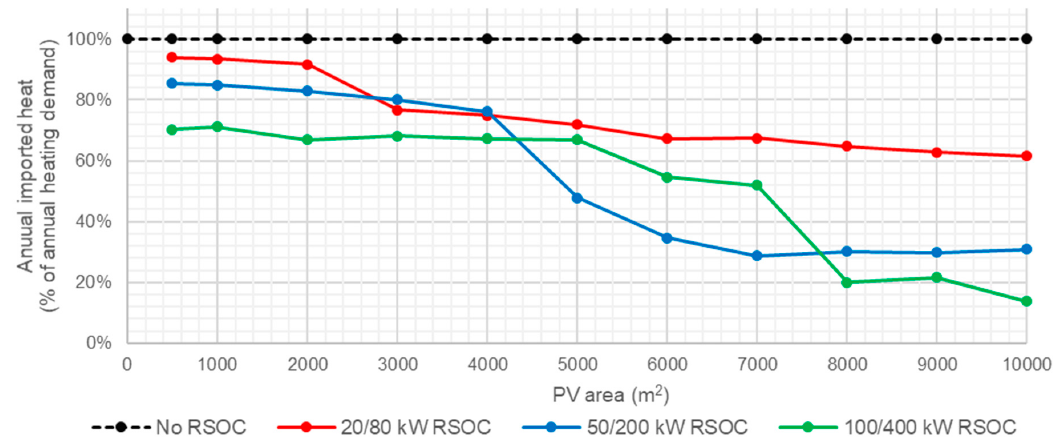
Figure 10. Annual imported heat (for the optimal hydrogen storage size) as a function of installed solar PV panel area for the three RSOCHS systems and the reference system.